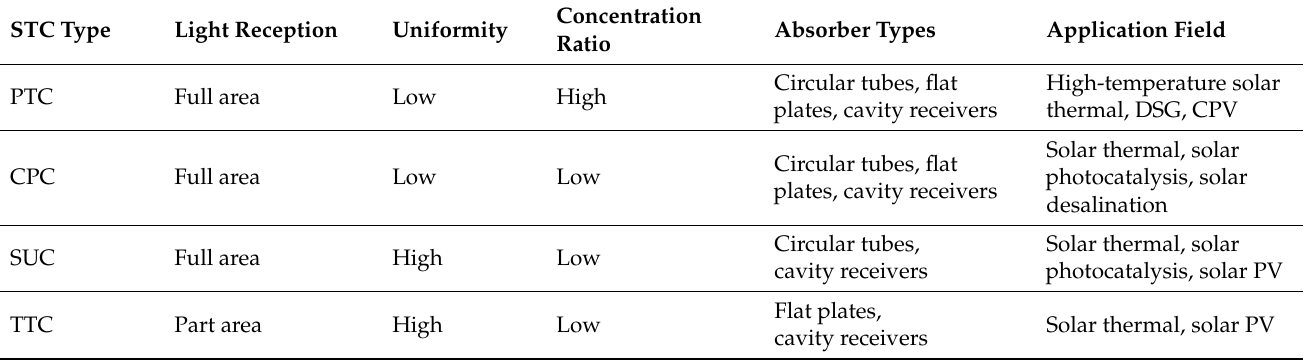
Table 4. STC application